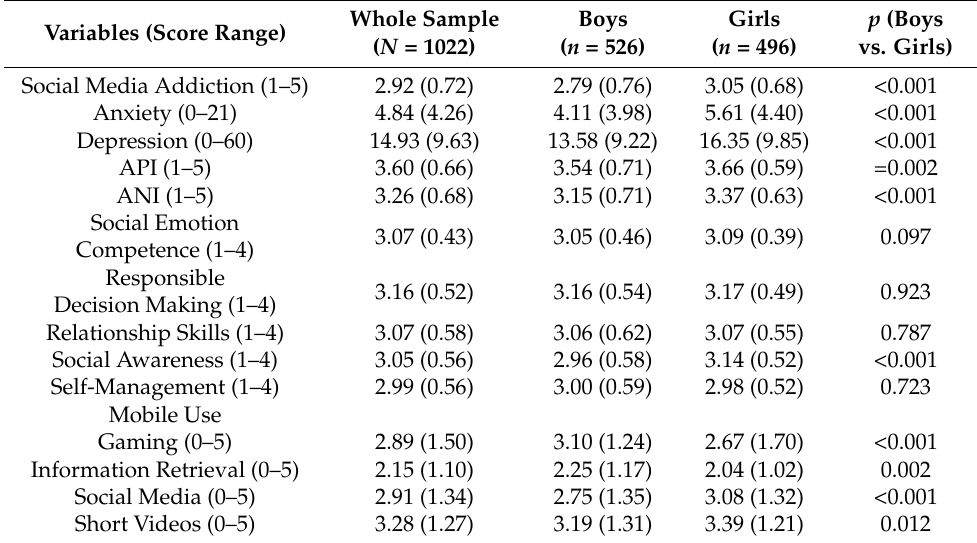
Table 1. Descriptive statistics for major study variables.